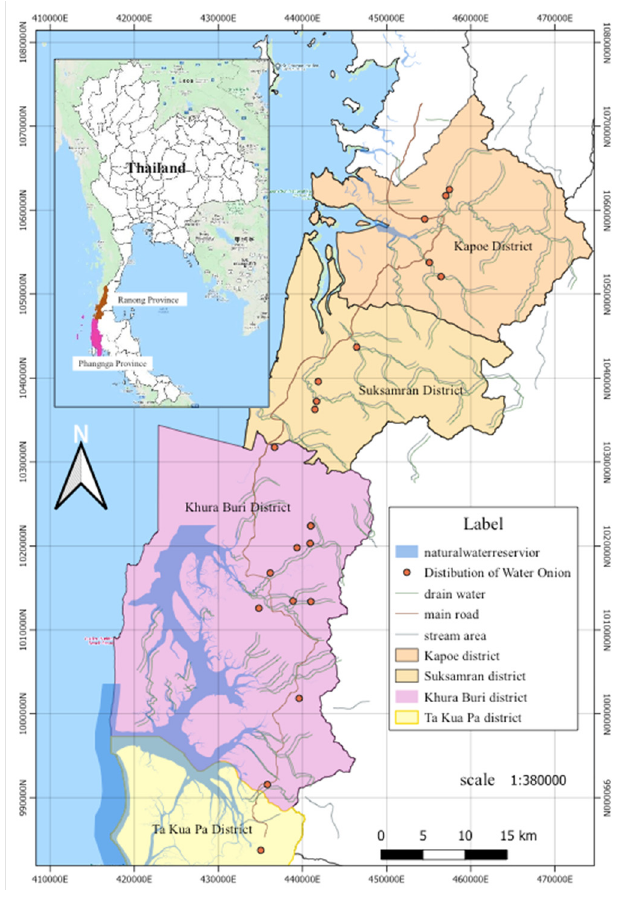
Figure 2. Study area and the distribution of WO in 2018. Note: The WO distribution is shown in red. Source: Adapted from Kongsuwon [74].